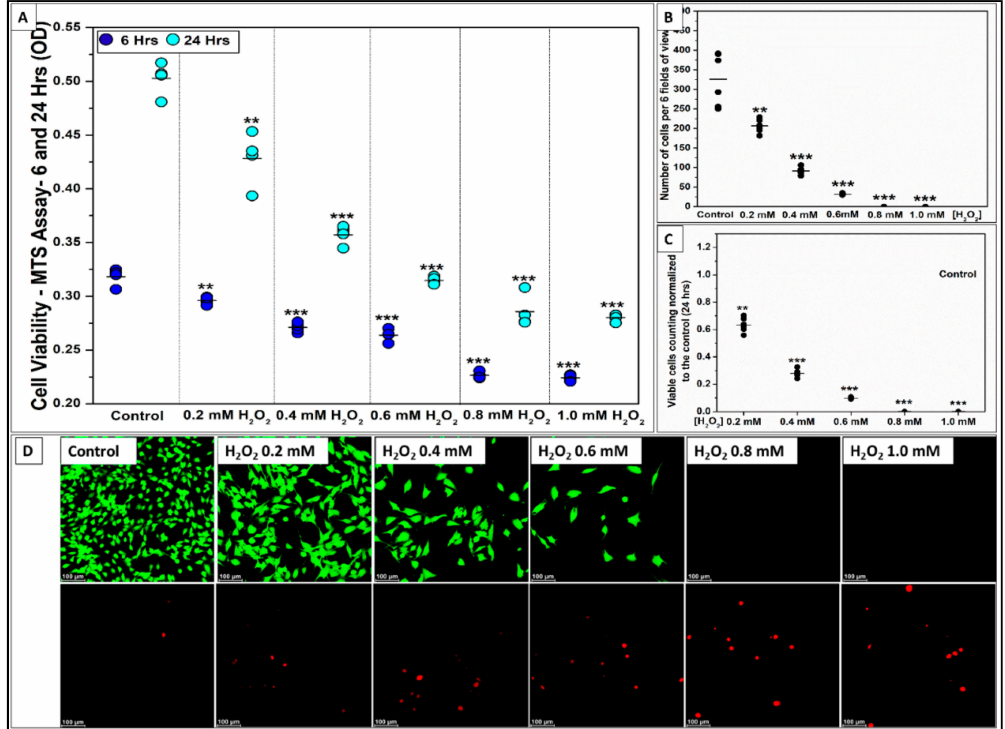
Figure 6. Effect of Hydrogen peroxide (H 2 O 2 , ROS-source) on C2C12 myoblast cell viability. ( A ) Data distribution graph presents the cell viability results using MTS assay after 6 and 24 h of C2C12 cell culturing in growth media with five different concentration of H 2 O 2 (0.2, 0.4, 0.6, 0.8, and 1.0 mM). 0.4 mM of H 2 O 2 into the growth media significantly decreases the cell viability after 6 and 24 h compared to the control (*** p < 0.001, ** p < 0.01, n = 4 per group). ( B ) Data distribution graph presents the number of cells per 6 fields of view confirming the same results from the MTS-assay. ( C ) Bar graph shows the number of viable cells normalized to the control after 24 h, 0.2 mM of H 2 O 2 decreased the number of viable cells to 63% and the 0.4 mM H 2 O 2 to ~30% viable cells compared to the control 100% (0 mM H 2 O 2 ). ( D ) Fluorescent pictures (20 × view) of C2C12 cells stained with live/dead assay kit shows the live (green) and dead (red) cells after being exposed to H 2 O 2 for 24 h. No viable cells were observed with 0.8 and 1.0 mM of H 2 O 2 . (—) in the graphs represents the mean and the scale bar on the fluorescent pictures is 100 µ